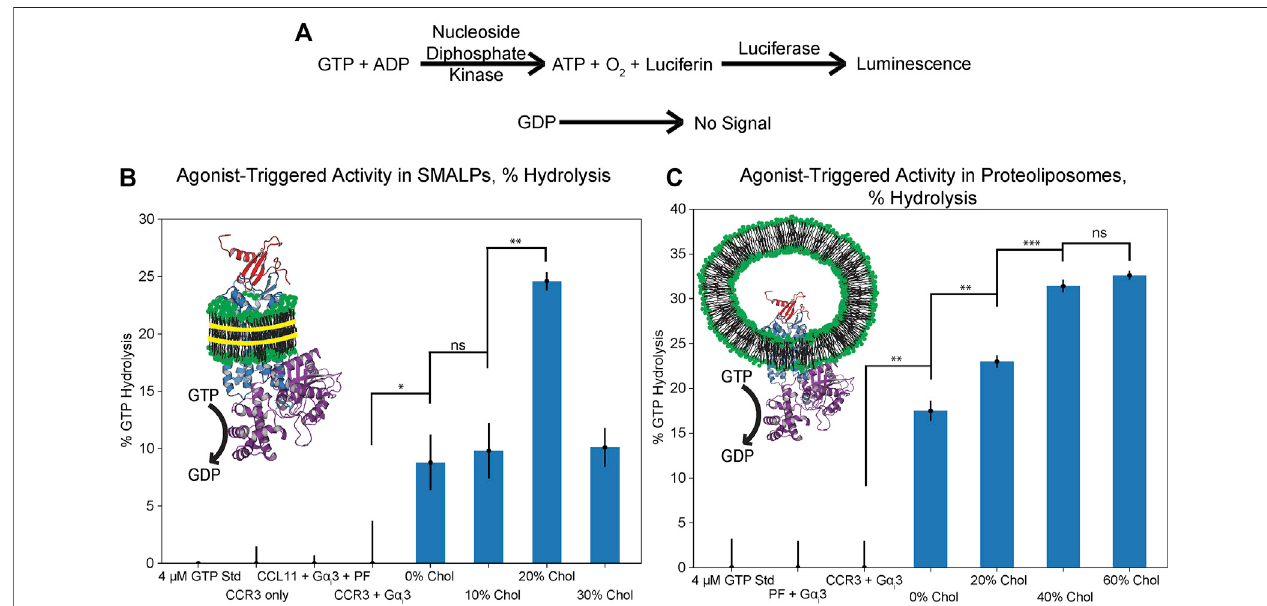
FIGURE 6 | GTPase assay results in SMALPs and proteoliposomes of increasing cholesterol content (mol% in PC), presented as % GTP hydrolyzed over the course of 2 h. (A) Schematic representation of GTP hydrolysis translation to the luminescent signal (Mondal et al., 2015). (B) Cholesterol enhances GTP hydrolysis in SMALPs but dose dependence could not be veri fi ed, likely due to inhibition of disc formation. (C) Cholesterol dose dependence of GTP hydrolysis is veri fi ed through coreconstitution ofCCL11with CCR3 into proteoliposomes. Cartoons depict CCL11 (red, 1EOT) (Crump et al., 1998) bound toCCR3 (blue) reconstituted inlipids (green headgroups) formed into either SMALPs with SMA (left, yellow) or proteoliposomes (right) with G α i 3 (purple, 2ODE) (Soundararajan et al., 2008) bound to CCR3. Pointsindicate the mean ± standard deviation for three replicates. Bars indicate statistical signi fi cance based on the Student ’ s t -test: * p < 0.05, ** p < 0.01, *** p < 0.001, ns is not statistically signi fi